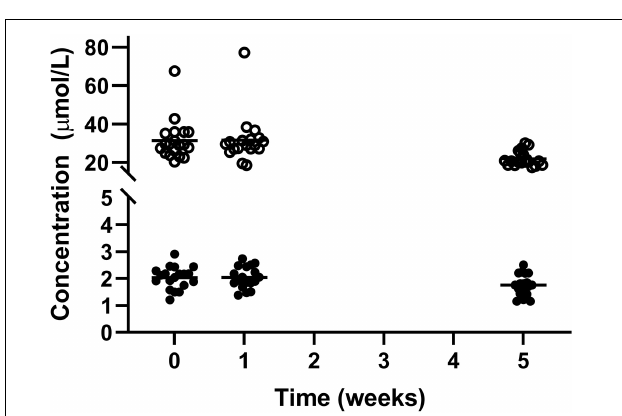
FIGURE 7 | Circulating vitamin B12 for the 19 participants who completed the study. The mean of each measurement shown as a solid black line.